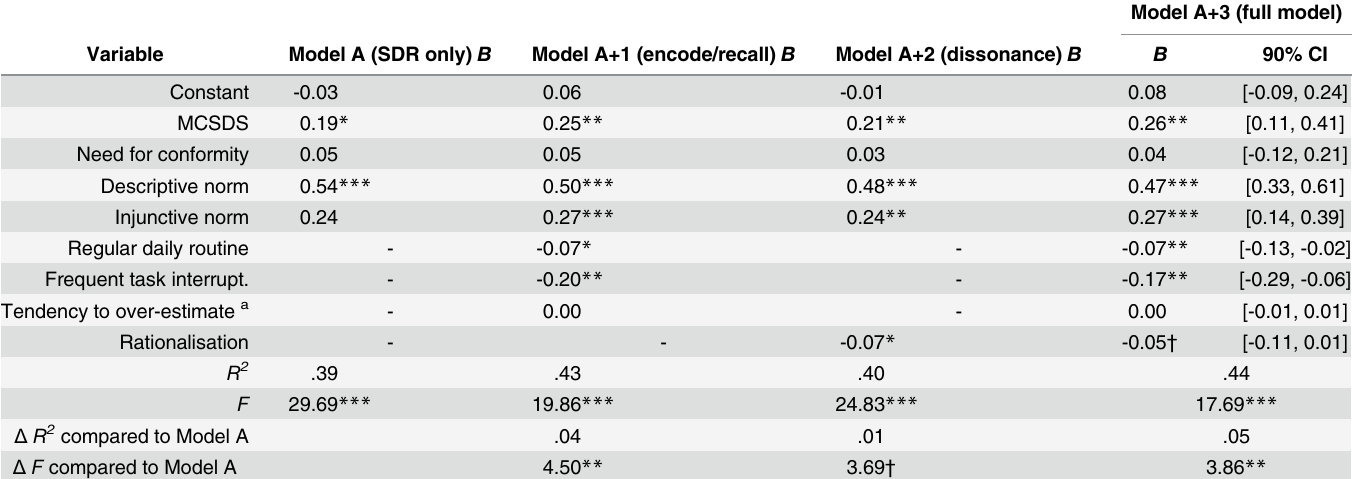
Table 3. Factors explaining over-reporting in stool-related handwashing: Multiple regression